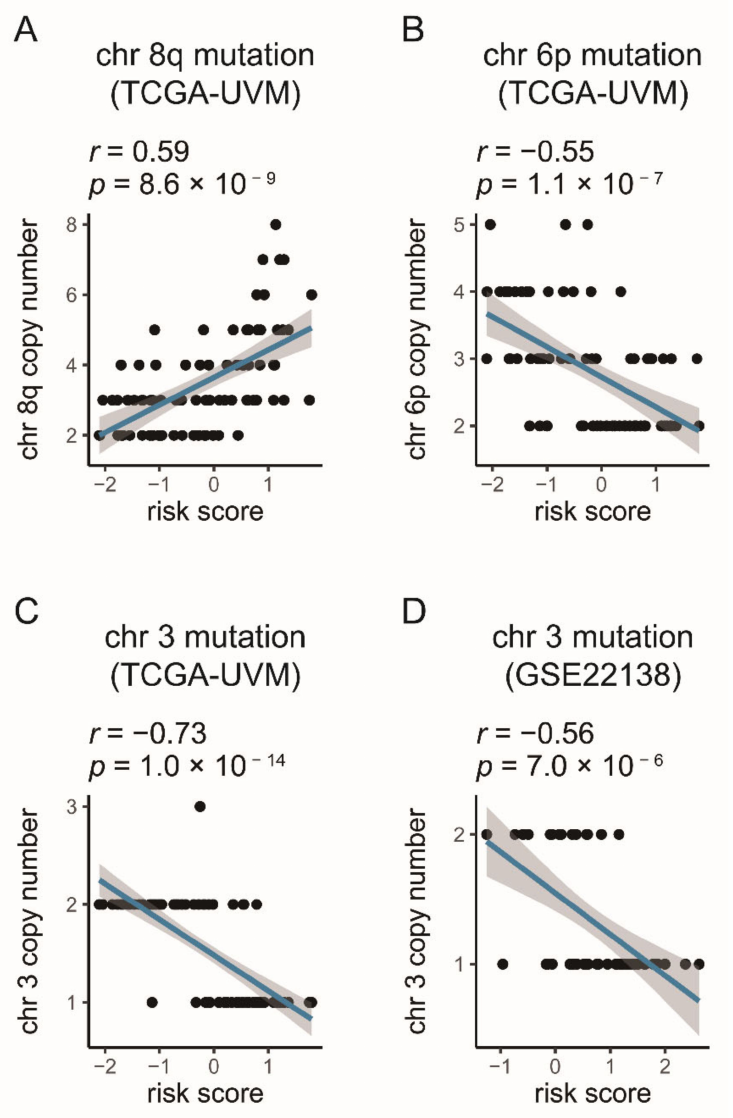
Figure 6. Correlations between the gene signature and the chromosome aberrations in UM ( A – D ). The blue line in each graph fits a linear model that indicates the proportional trend of copy number and the risk score. The grey shading around the blue line indicates the 95% confidence interval. The correlation examination was conducted by the Pearson